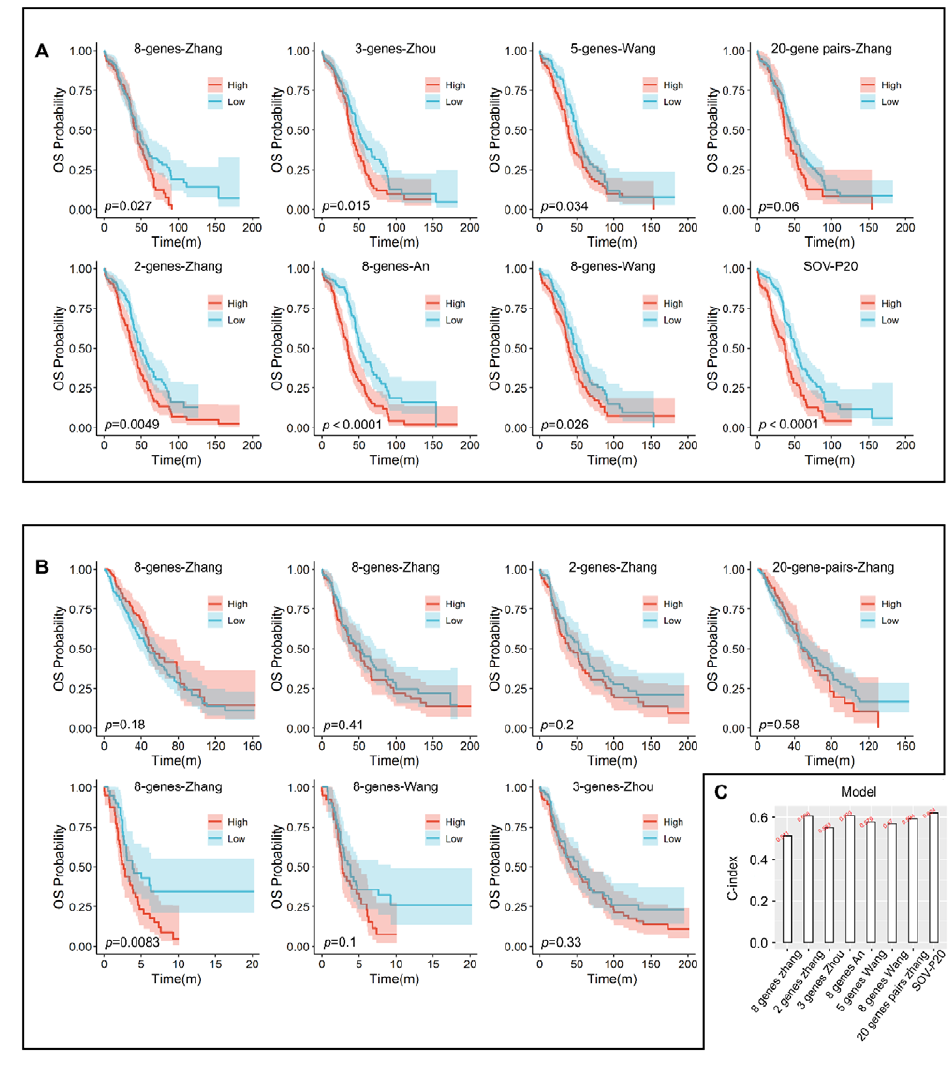
Figure 4. ( A ) Kaplan–Meier plots of the seven published models and SOV-P20 in TCGA-OV RNA sequencing data; ( B ) Kaplan–Meier plot of the seven published models in validation set; ( C ) bar plot of C-index values for the seven published models and SOV-P20.